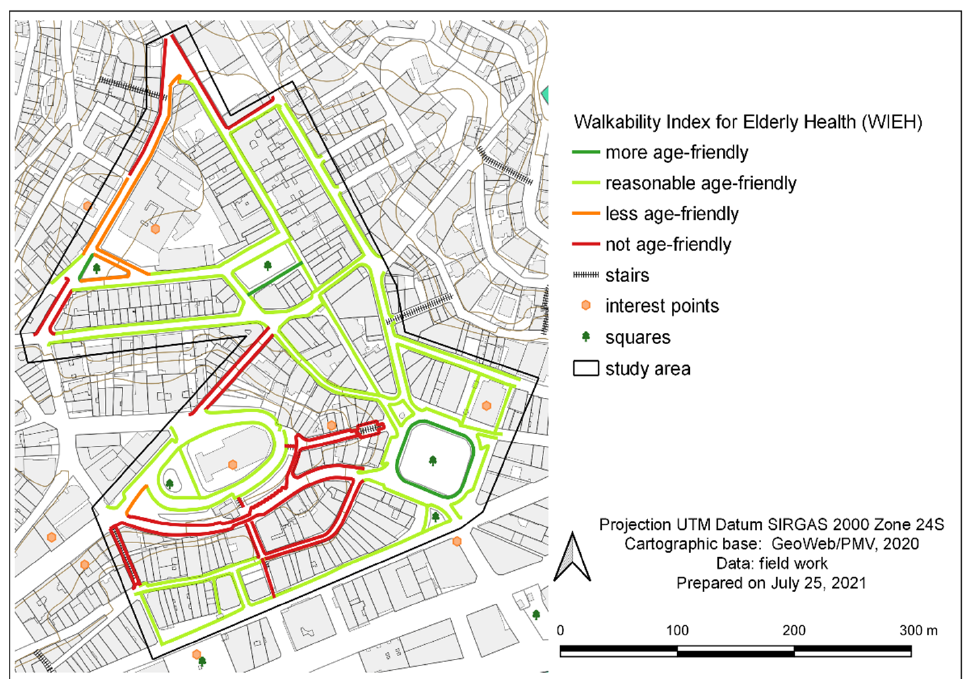
Figure 9. Classification of sidewalks according to the Walkability Index for Elderly Health (WIEH).